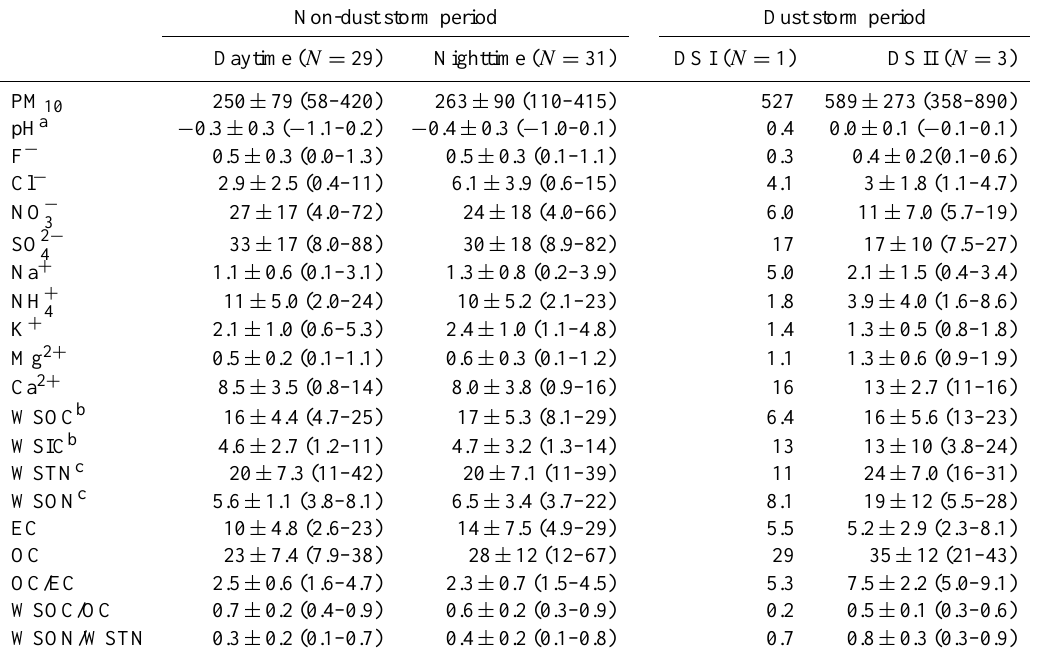
Table 1. Concentrations of water-soluble species, elemental carbon (EC) and organic carbon (OC) of PM 10 during the spring 2009 in Xi’an, China, µgm − 3